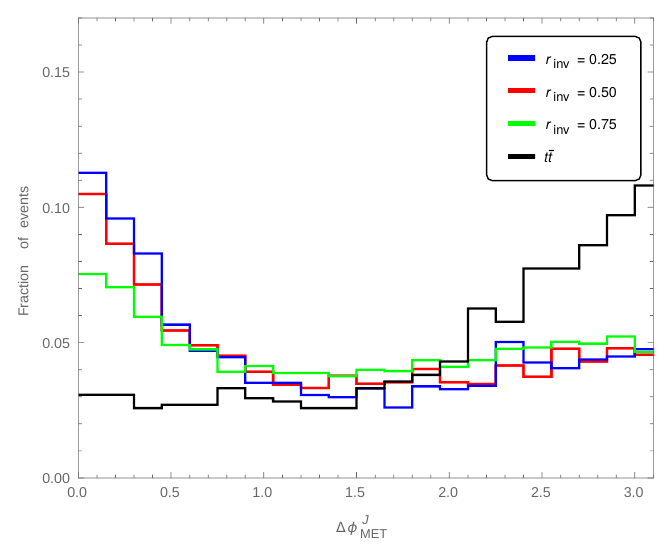
Figure 9. Normalized distribution of (cid:1) (cid:30) J The mass m X was taken to be 500 GeV and the coe(cid:14)cients were set to y F were applied beforehand as described in the